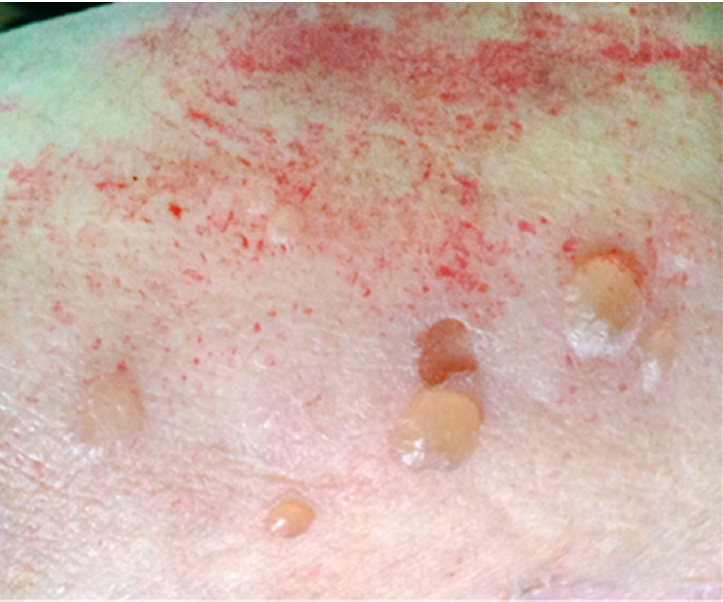
Figure 1. Blistering skin lesions on erythematous base on the right arm. She had a history of type 2 diabetes, hypertension, and stroke (5 years before), resulting in hemiplegia of the upper and lower right limbs; no history of allergy, autoimmunity, or cancer was referred. The patient had been on furosemide and vildagliptin for one